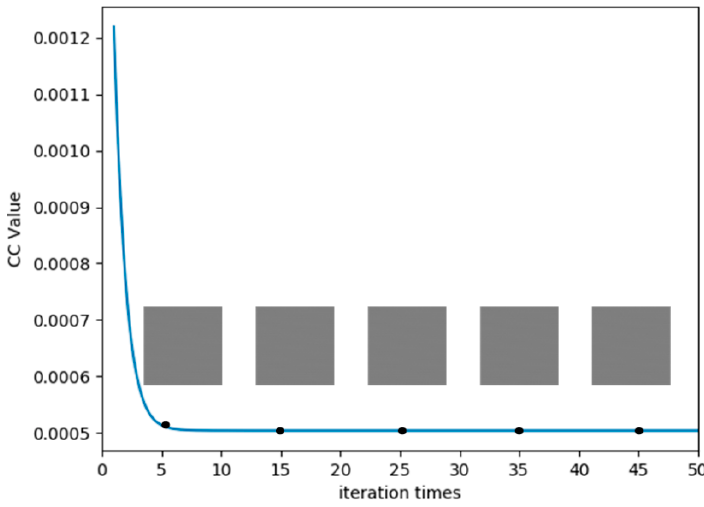
Figure 10. Decryption results of chosen-plaintext attack without key ( a ) R, ( b ) r, ( c ) λ , ( d ) 2D kernel.